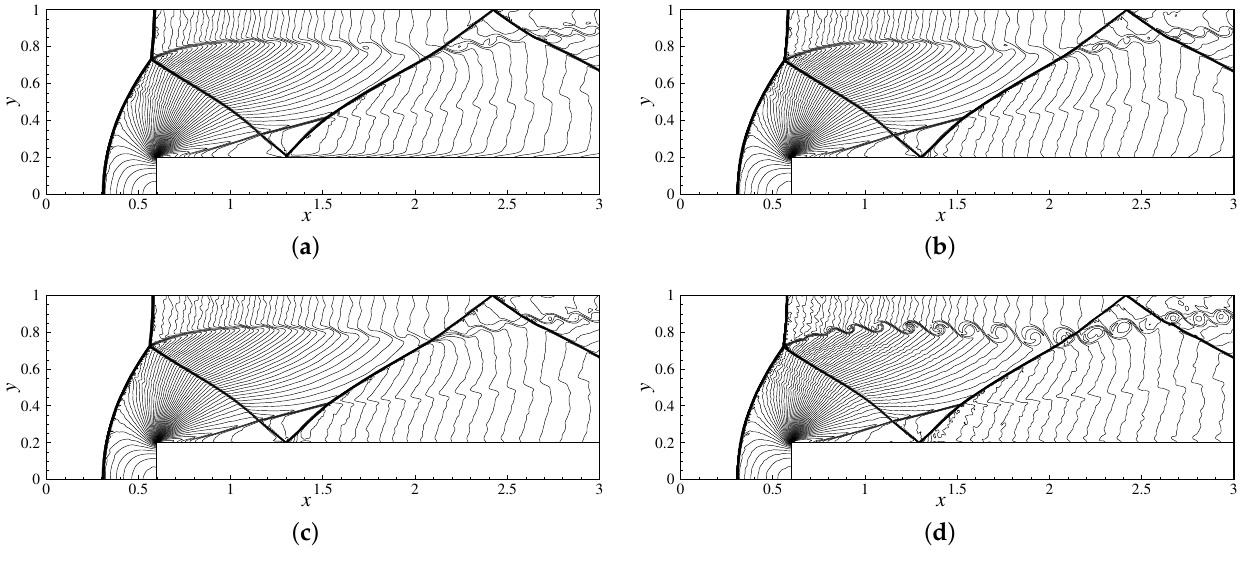
Figure 20. Density contours of the forward facing step problem with 601 × 201 grid points. 60 equally distributed contours ranging from 0.2568 to 6.607: ( a ) WCNS5-JS; ( b ) WCNS5-Z; ( c ) WCNS5-AS; ( d )